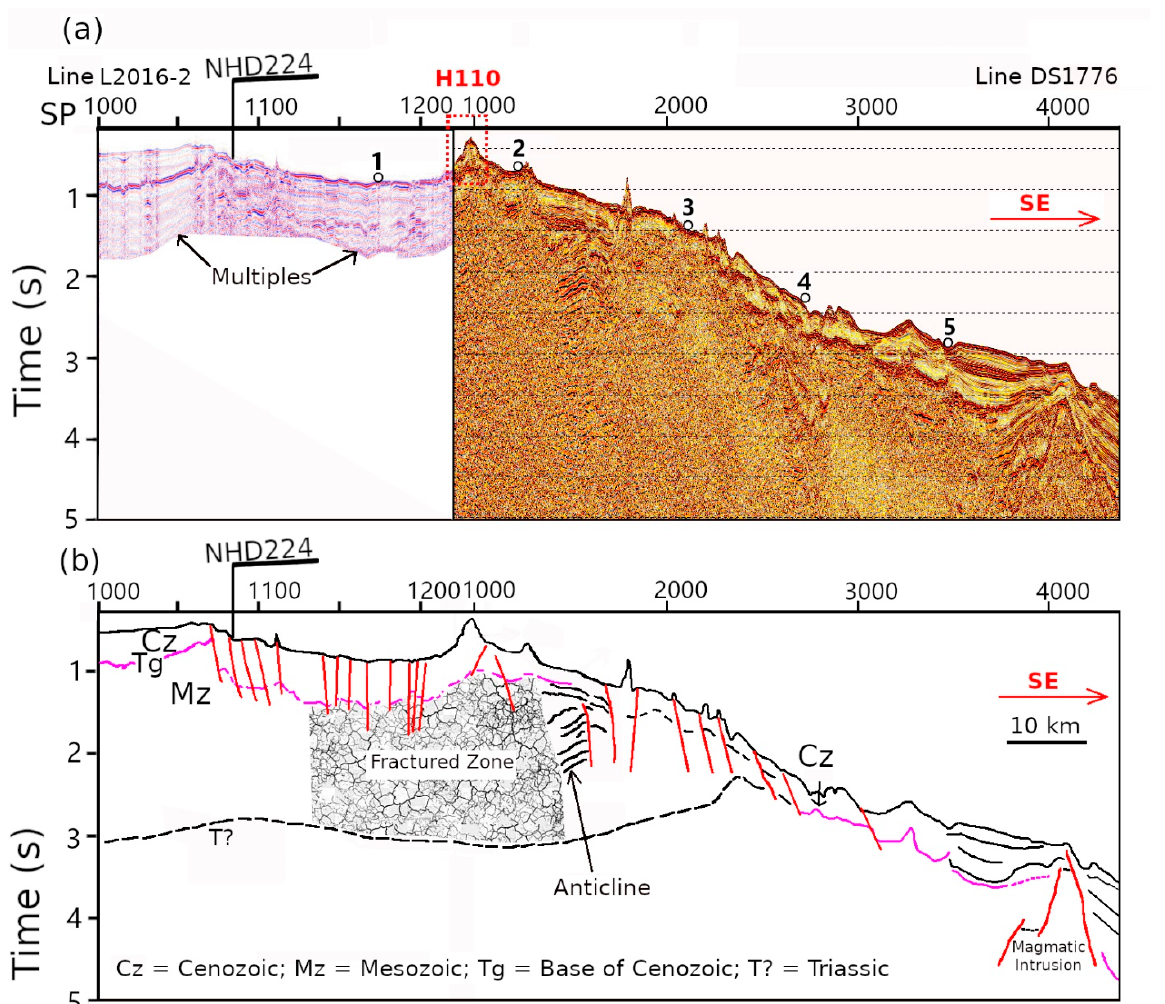
Figure 9. A composite MCS profile of L2016-2 and DS1776 ( a ) and interpretation ( b ). There shows several outcrop hills in the upper slope and buried ones in the lower slope. Because of multiples, the section below 1.8 s in the L2016-2 profile is not shown.